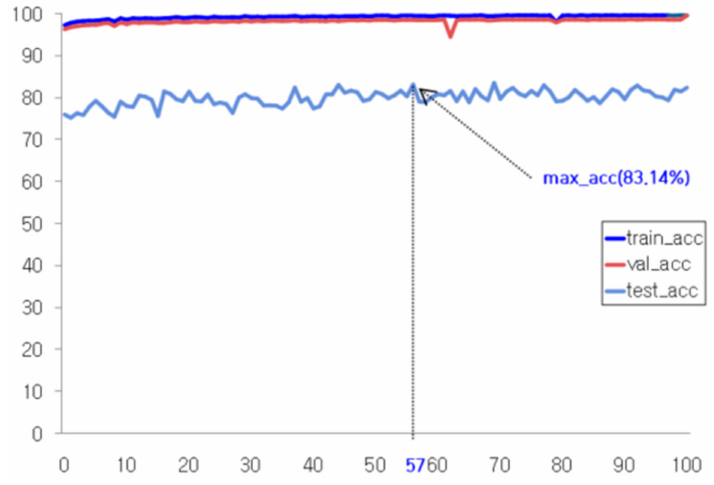
Figure 7. Accuracy of the classification model.